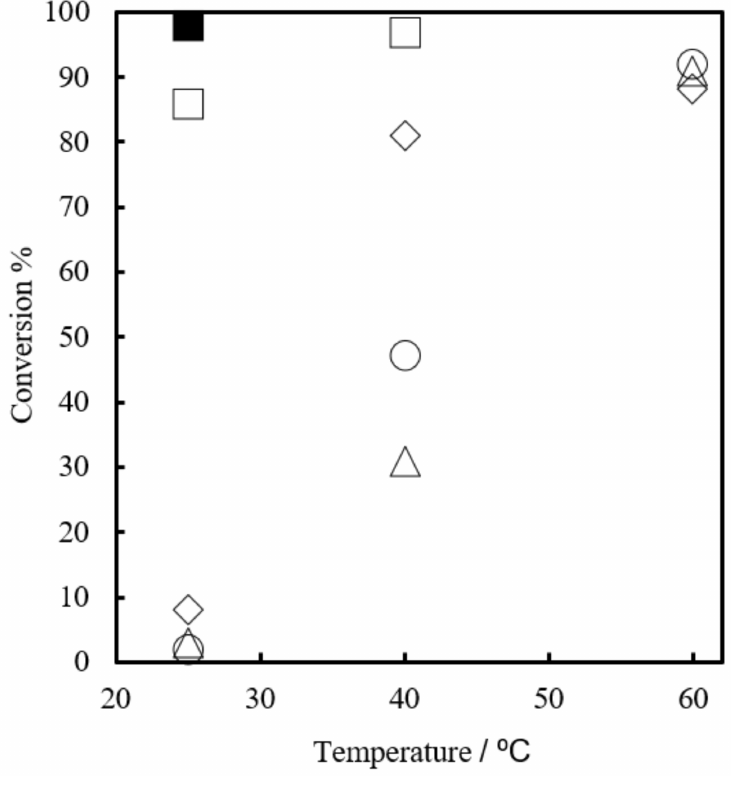
and C (%) = 8.5 T (h) (%Conversion = coefficient × hour time) for α -ZrP · 0.22DBU and α -ZrP · 0.10DBU